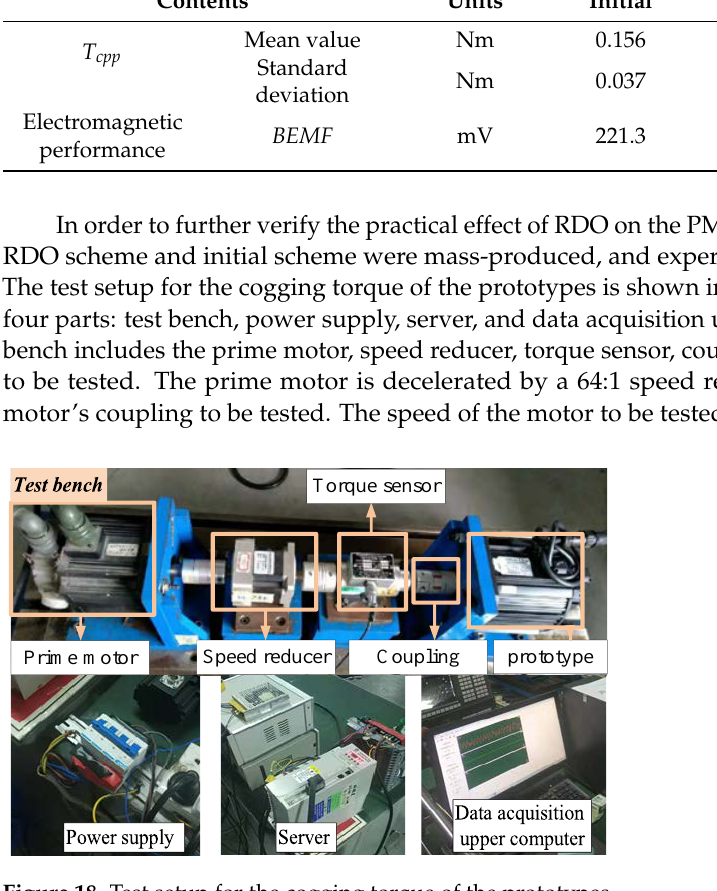
Table 6. Robustness and performance comparison of the PMSM before and after optimization.